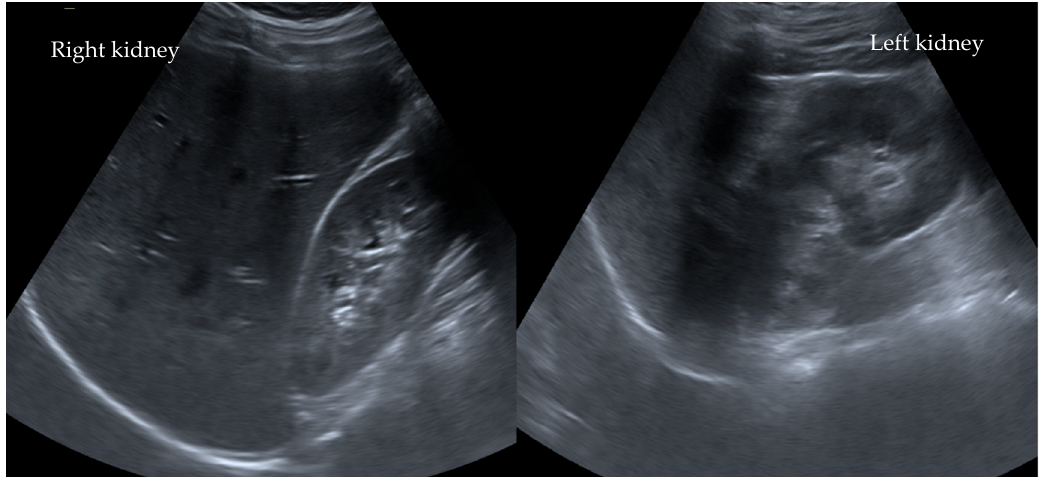
Figure 1 . No parenchymal pathologies observed ultrasonographically in the kidneys after ibuprofen misuse in Case I°. Ultrasonographically, there are no parenchymal changes, medullary pyramids, especially sonomorphologically laterally symmetrical and inconspicuous with good corticomedullary parenchymal differentiation. The kidneys are normal in size. The resistance index is laterally symmetrical and normal for age.